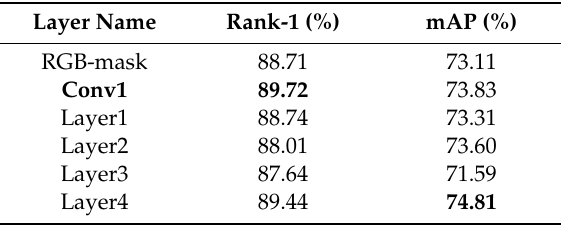
Table 2. Performance on Market 1501 with mapping on di ff erent layers.